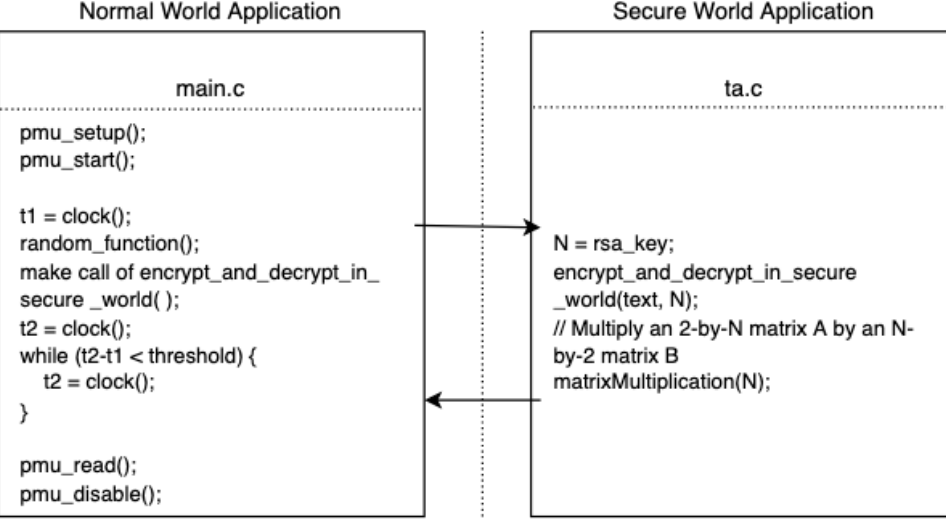
Figure 5. The code used in the asynchronous attack